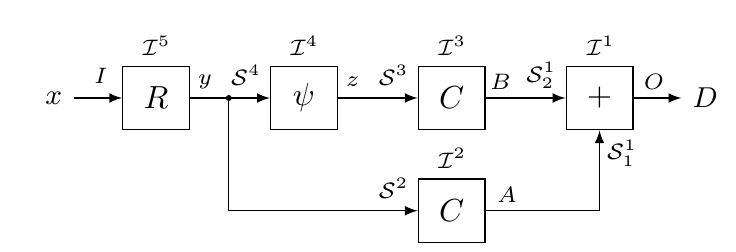
Figure 6: The sequence of gadgets in the Boolean to arithmetic conversion